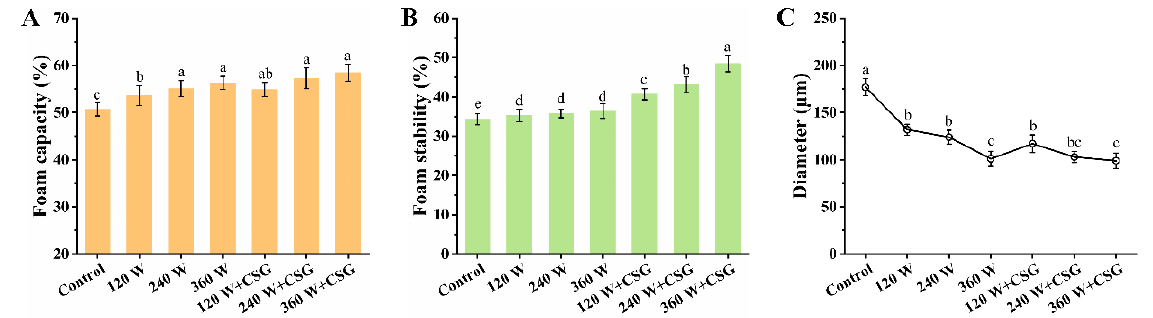
Figure 1. Foam capacity ( A ), foam stability ( B ), and average foam diameter ( C ) of WPI and WPI–CSG systems treated by different power ultrasounds. Different lowercase letters represent significant differences ( p < 0.05) between data.